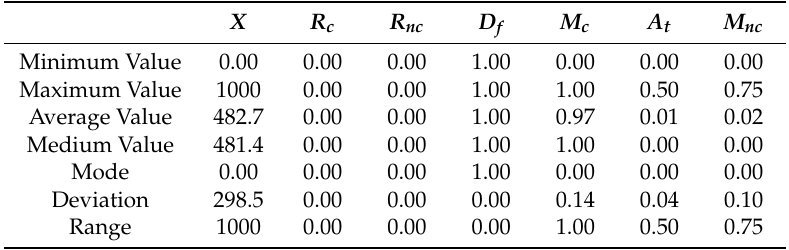
Table 5. Statistical analyses of strategies R c , R nc , D f , M c , A t , and M nc .